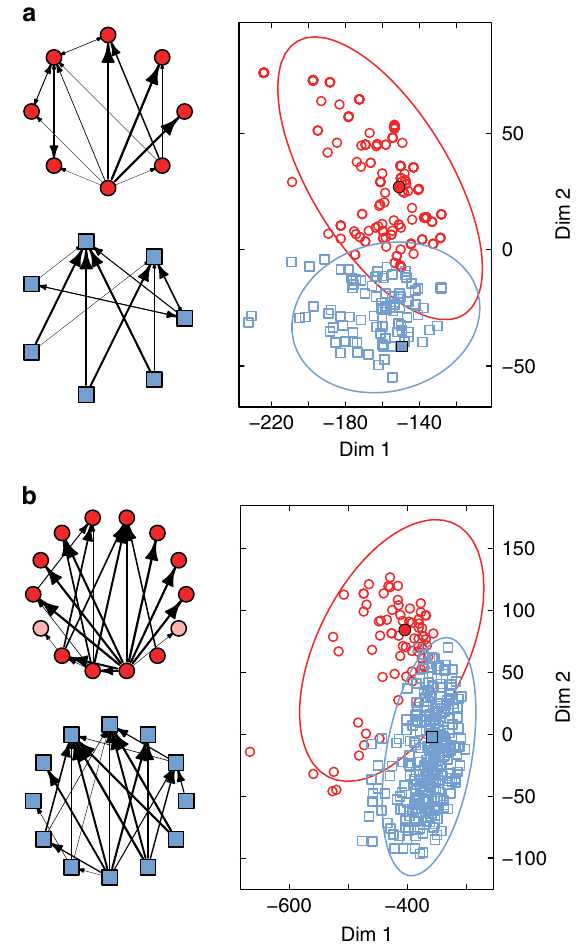
Fig. 4 Visualization of the backbones of interactions found across all food webs. a Analysis for the 6-link backbones of interactions. On the right, we show a representation of the clustering analysis for the dissimilarity matrix E 6 , where every point represents the backbone from a different network. The red and blue network structures depicted on the left characterize the distinct backbones identi fi ed within each of the two clusters. They are found by selecting the medoids of the clusters (indicated by the black circle and square) and overlapping them with all the within-cluster backbones, following the example shown in Fig. 1c. In these red and blue structures, the weight of the links is proportional to the likelihood l of fi nding them in the backbones. Note that links that were not signi fi cantly represented in the backbones ( l < 0.01) are not shown. b We show the same analysis but for the 15-link backbones of interactions. The light-red nodes in the top structure indicate nodes that signi fi cantly appears in the backbones but not in the